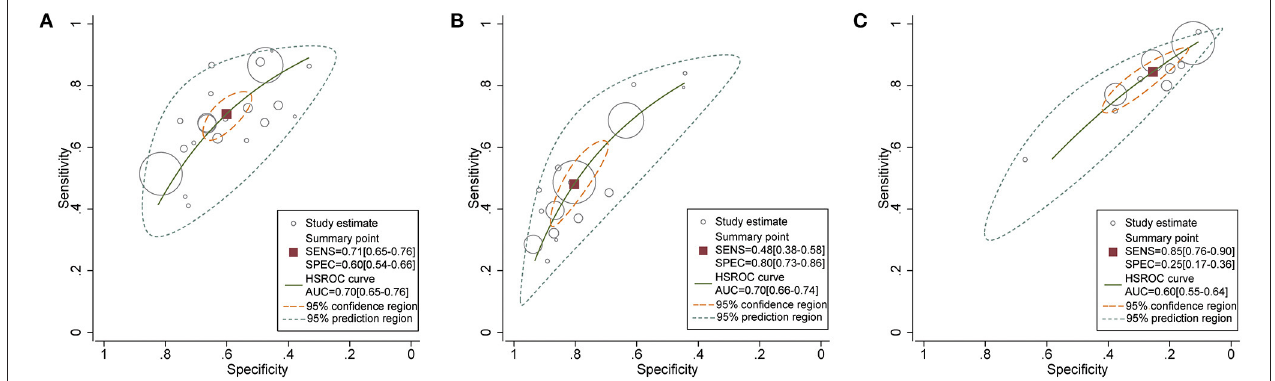
FIGURE 3 | Hierarchical summary ROC curves for (A) NEWS, (B) qSOFA, (C) SIRS for predicting mortality for patients with infection outside the ICU.